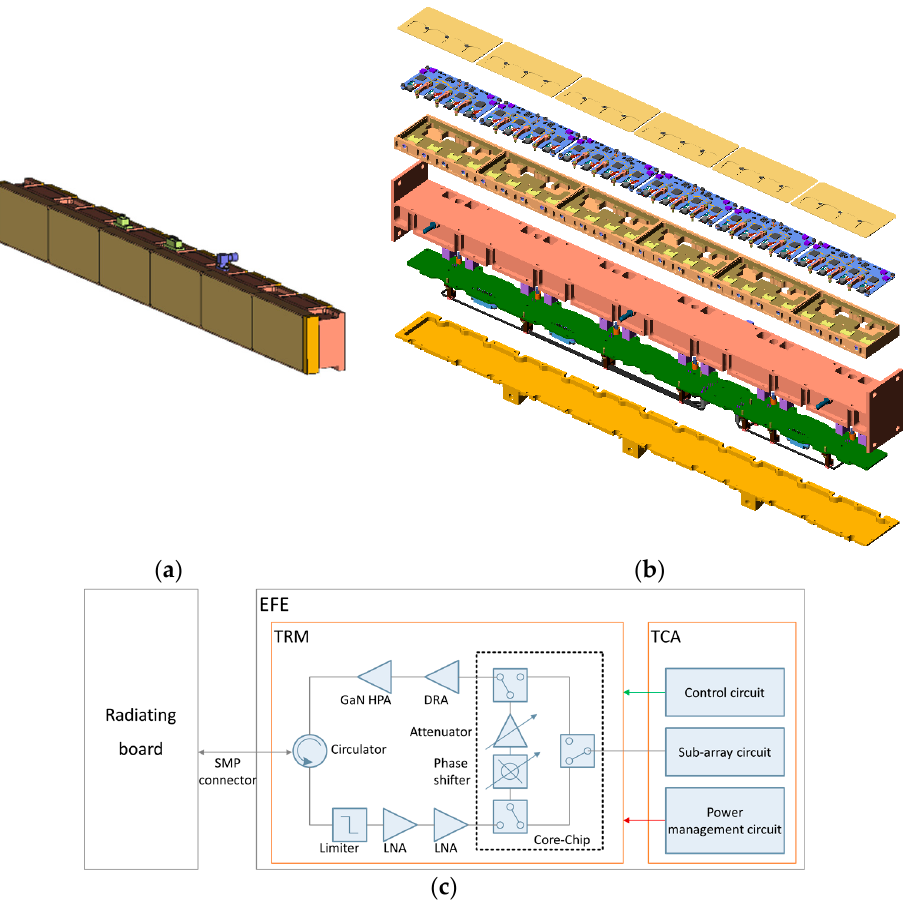
Figure 12. ( a ) Configuration of the electronic front-end (EFE) assembly, ( b ) exploded view of the EFE, and ( c ) architecture of the transmit/receive module (TRM) of the S-STEP SAR antenna